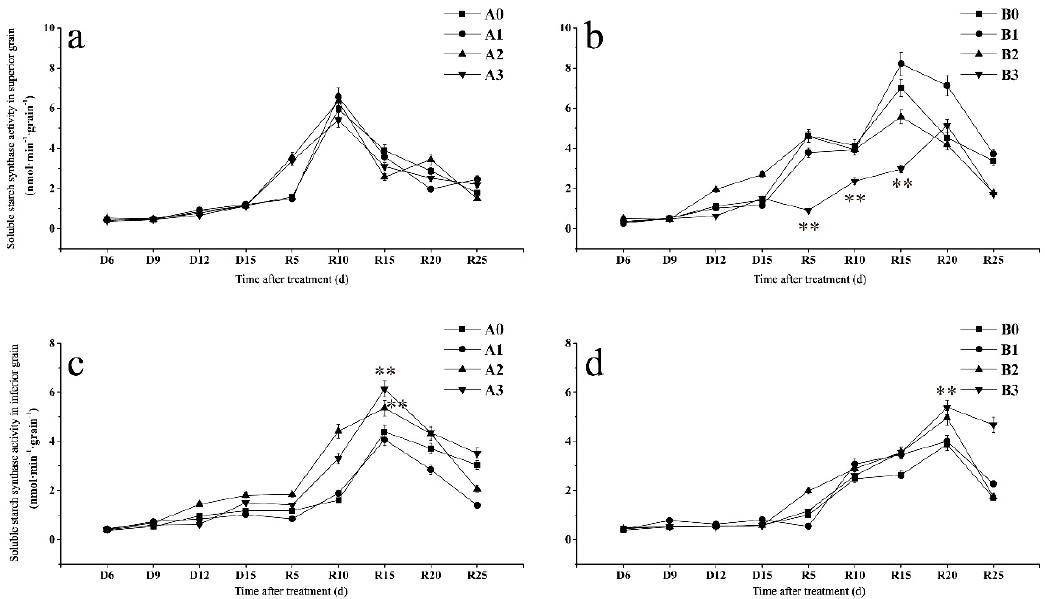
Figure 4. Effects of drought stress at the jointing–booting stage on soluble starch synthase activity of superior ( a , b ) and inferior ( c , d ) grains in growth period overlapping rice. ** represent significance at p < 0.01, respectively.